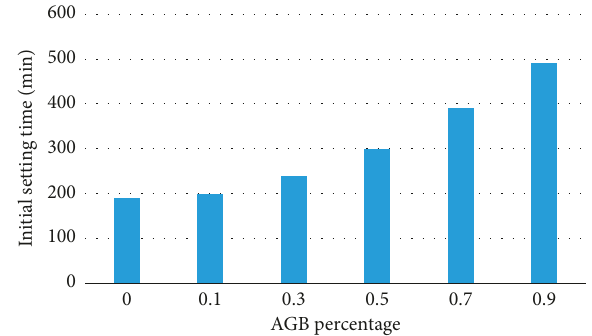
Figure 4: Initial setting time with different percentage of